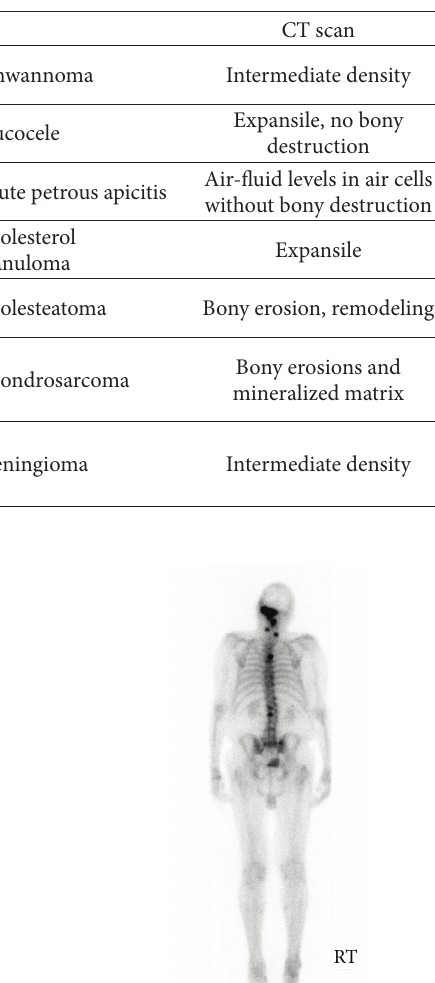
Table 2: Imaging characteristics of temporal bone lesions.